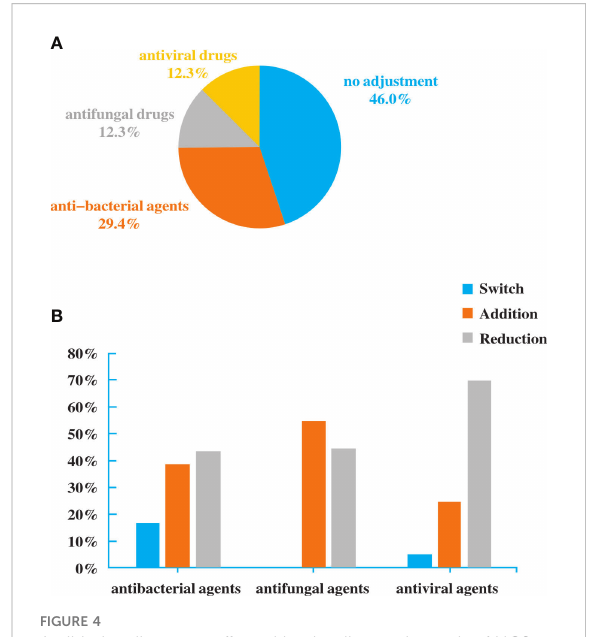
FIGURE 4 Antibiotic adjustment affected by the diagnostic result of NGS. (A) . Bacterial spectrum. (B) . Fungal